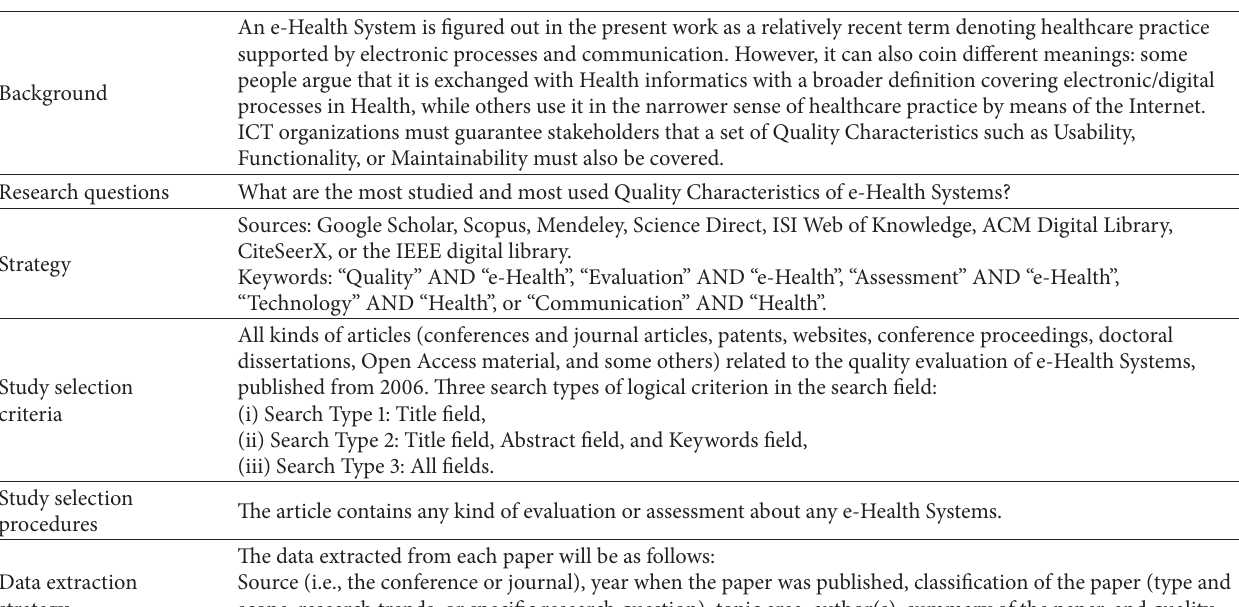
Table 1: The review